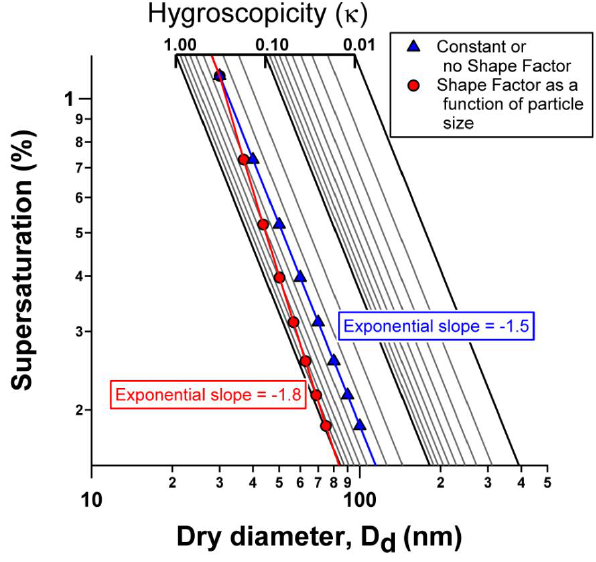
Figure 9. Variation of κ -Köhler isolines when applying a constant- Figure 9: Variation of κ -Köhler isolines when applying a constant or no shape factor and 811 or no-shape factor and applying a shape factor as a function of parti- applying a shape factor as a function of particle size. The blue triangles have a critical 812 cle size. The blue triangles have a critical supersaturation that scales supersaturation that scales with d d -3/2 due to a constant shape factor being applied while the red 813 − 3 / 2 with d due to a constant shape factor being applied while the circles scale with d d -1.8 due to the χ - d mobility relationship from Fig.4 being applied. 814 d red circles scale with d − 1 . 8 due to the χ − d mobility relationship d from Fig. 4 being